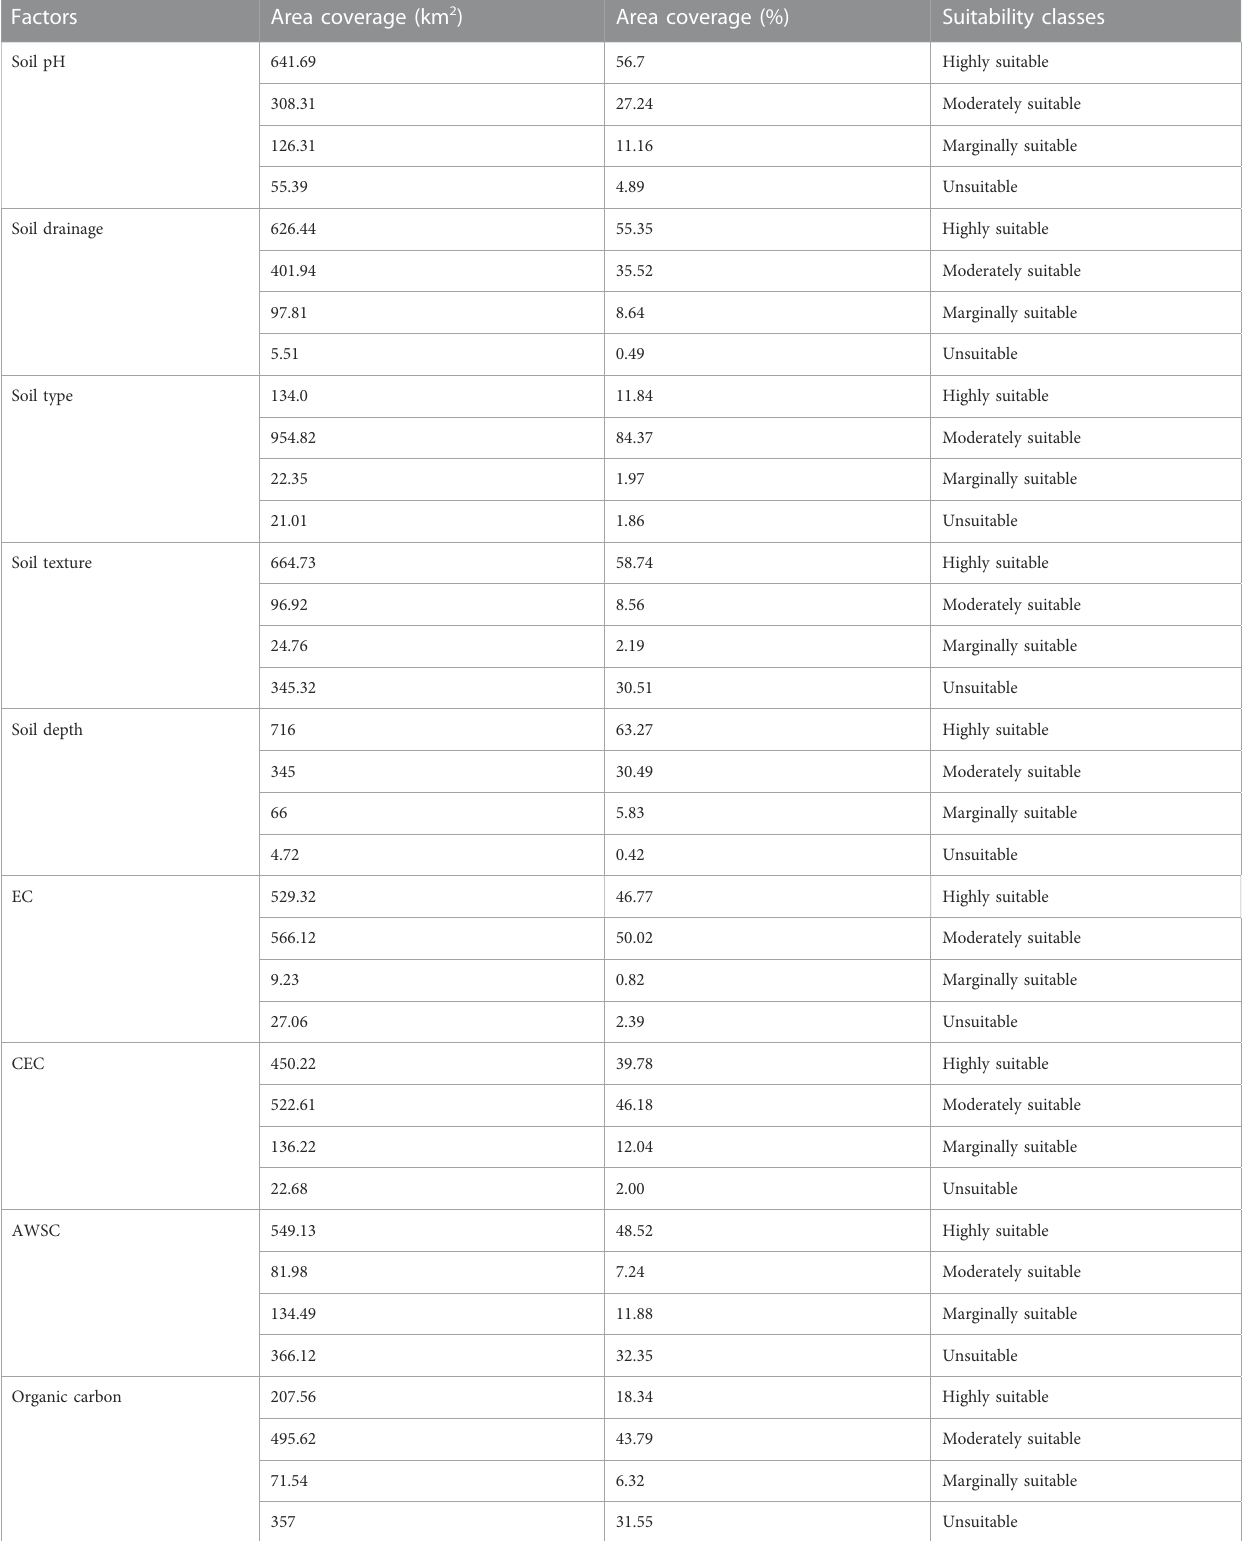
TABLE 6 Suitability analysis of the physical and chemical properties of the soils to determine the surface irrigation potentials of the Chacha Watershed.